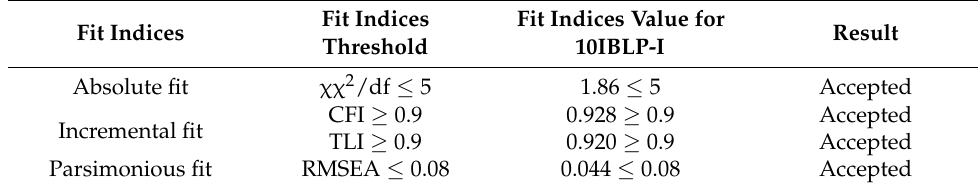
Table 6. Model fit for 10IBLP-I.